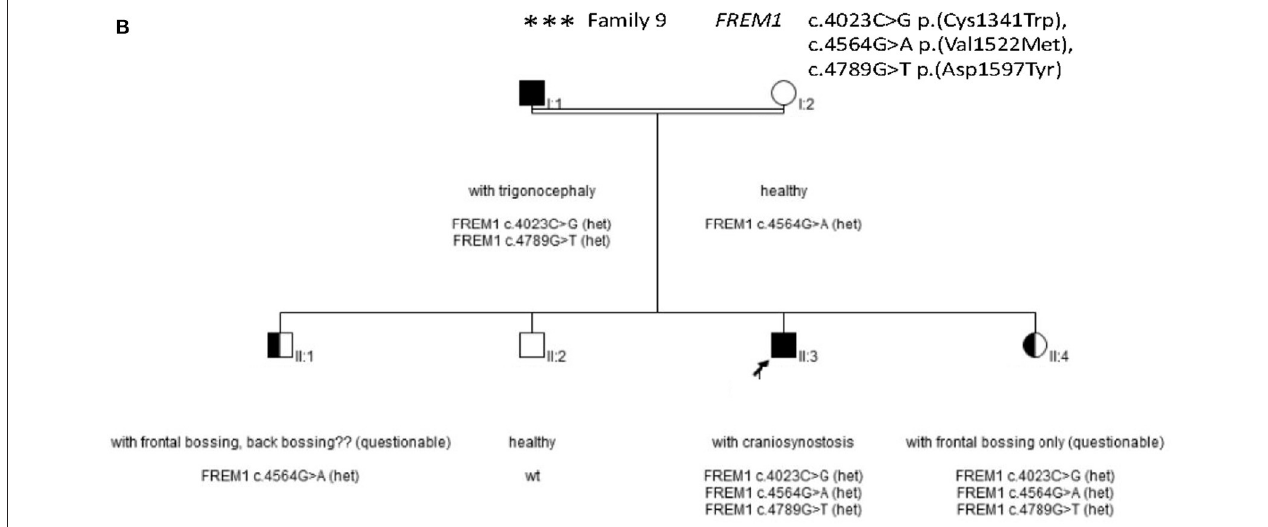
FIGURE 1 | Family pedigree with sanger sequencing result for all family (28 families) including all informative family members. (A) Families 1–8, 10–28. (B) Family 9.